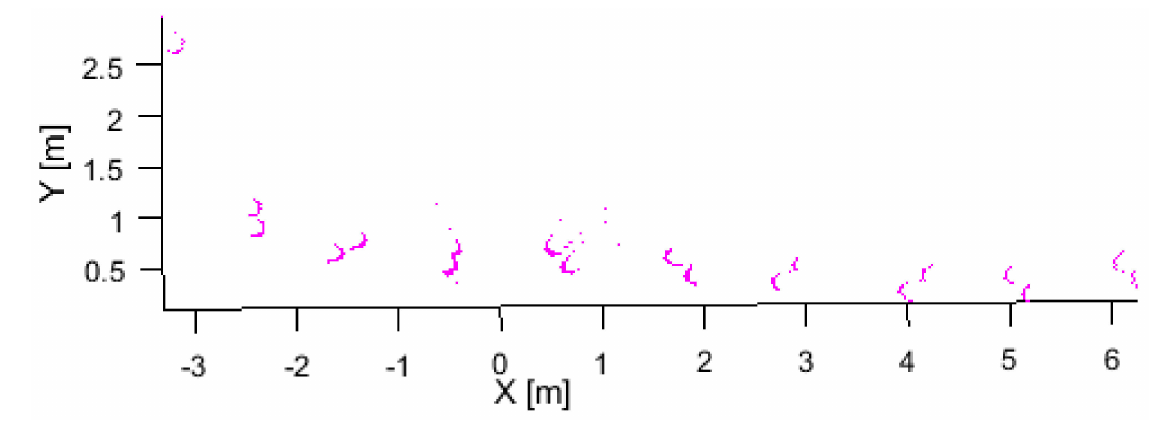
Figure 9. Dynamic objects found in static environment.